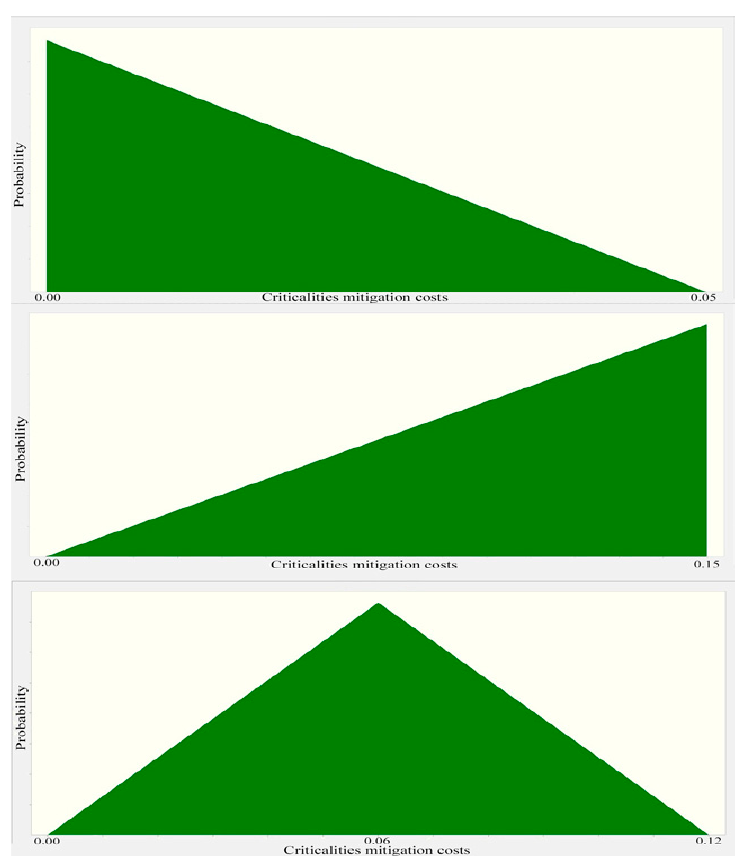
Figure 3. Probability distribution of the cost of mitigating the criticalities of the Superbonus in the case of small residential properties (top image), multi-family buildings renovated before the introduction of CILAS (central image), and multi-family buildings renovated after the introduction of CILAS (bottom image).